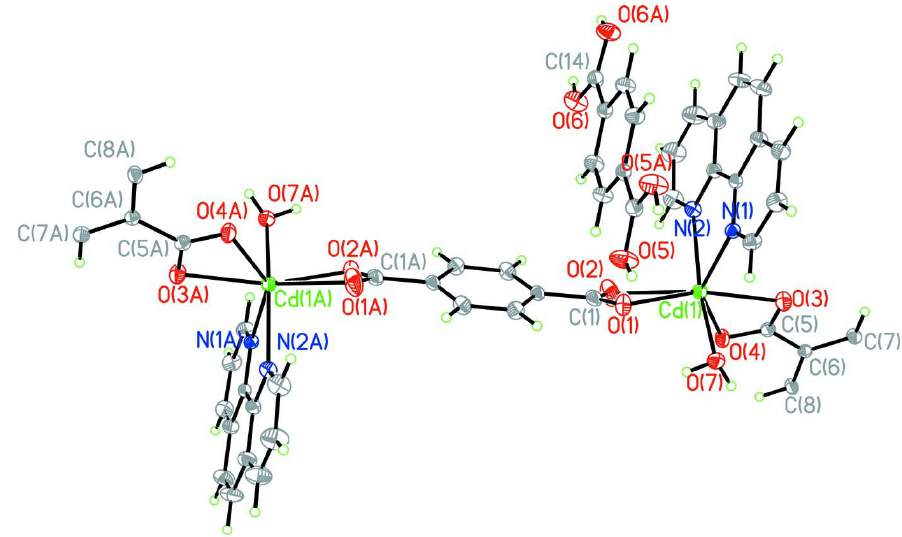
Figure 1 The asymmetric unit in the structure of compound (I). Displacement ellipsoids are drawn at the 30% probability